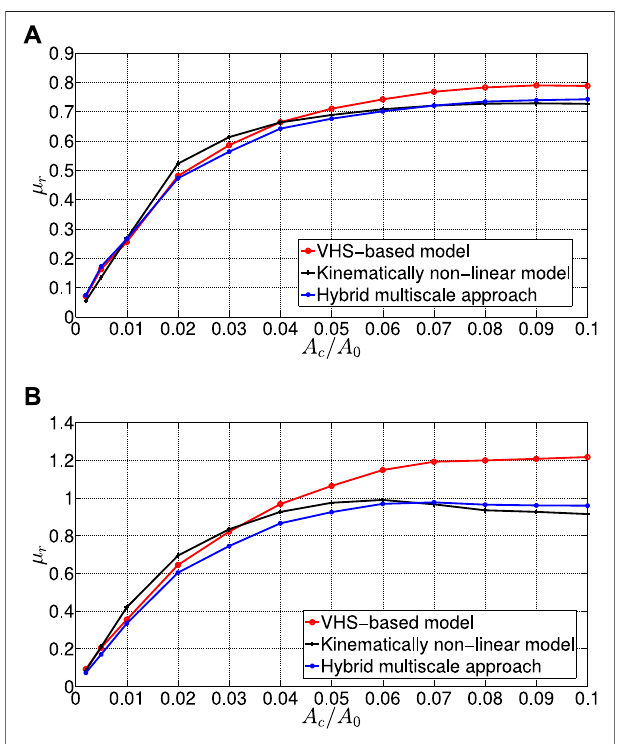
FIGURE 5 | Friction coef fi cient as a function of the normalized contact area for a surface roughness resulting from the superposition of three sinusoidal waves at a velocity of (A) 10 [mm/s], and (B) 50 [mm/s].